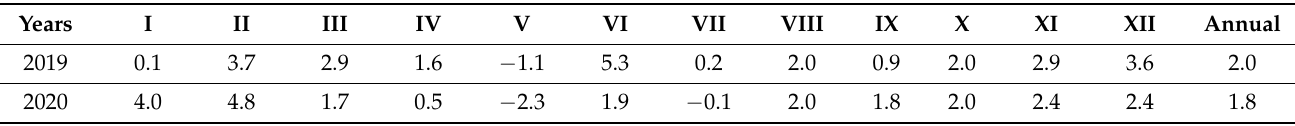
Table 1. Mean air temperature anomalies in ◦ C (compared to the 1991–2020 reference period) by month in Poland. Data source: https://meteomodel.pl/ (accessed on 10 April